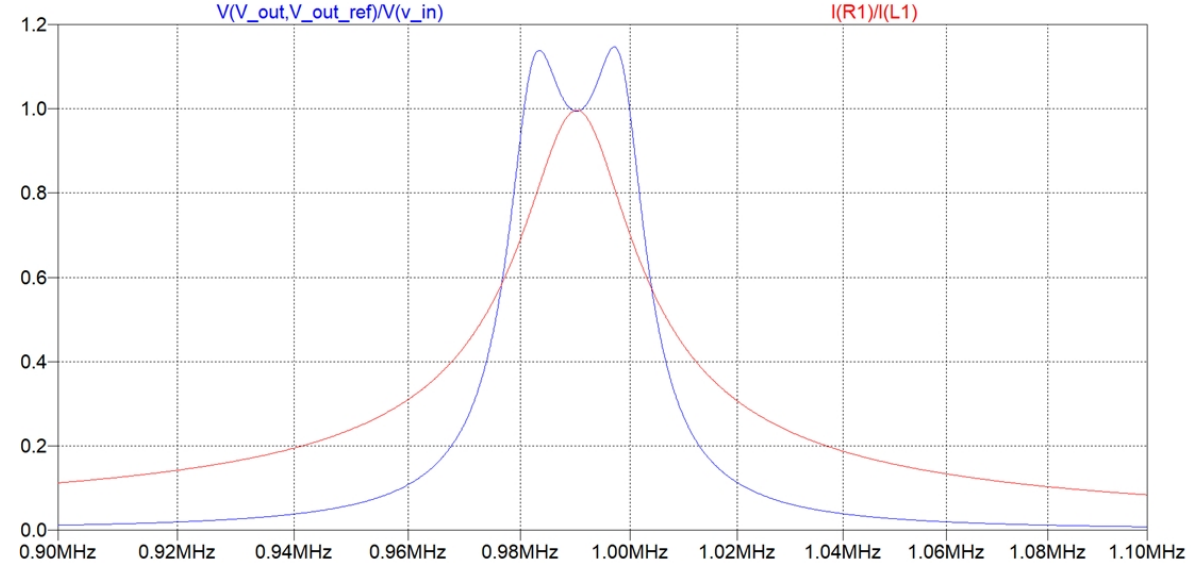
Figure 13. G V and G I behavior.